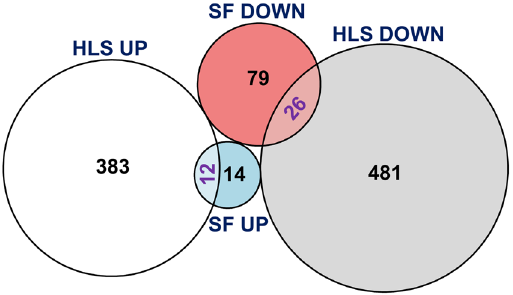
Figure 7. Euler diagram showing the up- and down-regulated genes altered by HLS and SF and their relationships. The area of each disjoint shape is proportional to the number of its elements as marked. SF, spaceflight; HLS, hindlimb suspension.